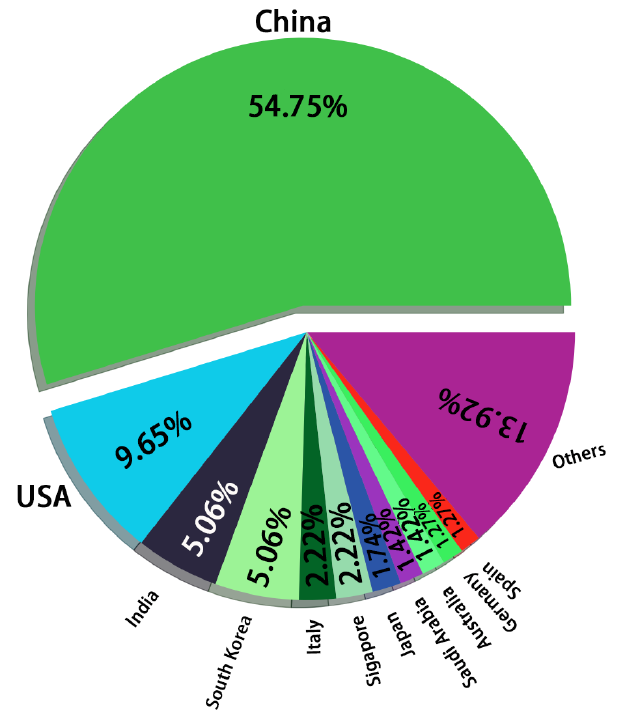
Figure 5. A pie chart of papers contributed by different countries.